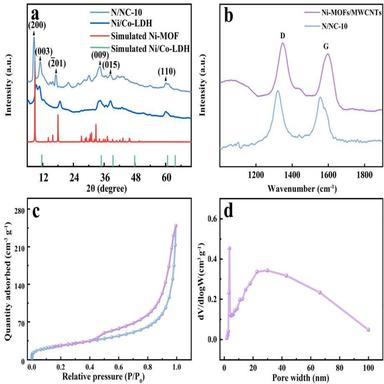
XRD patterns of N/NC-10, Ni/Co-LDH, stimulated Ni-MOF and stimulated Ni/Co-LDH (a), Raman spectra of Ni-MOFs/MWCNTs and N/NC-10 (b), and N2 adsorption-desorption isotherm (c) and pore size distribution plot of N/NC-10 (d).